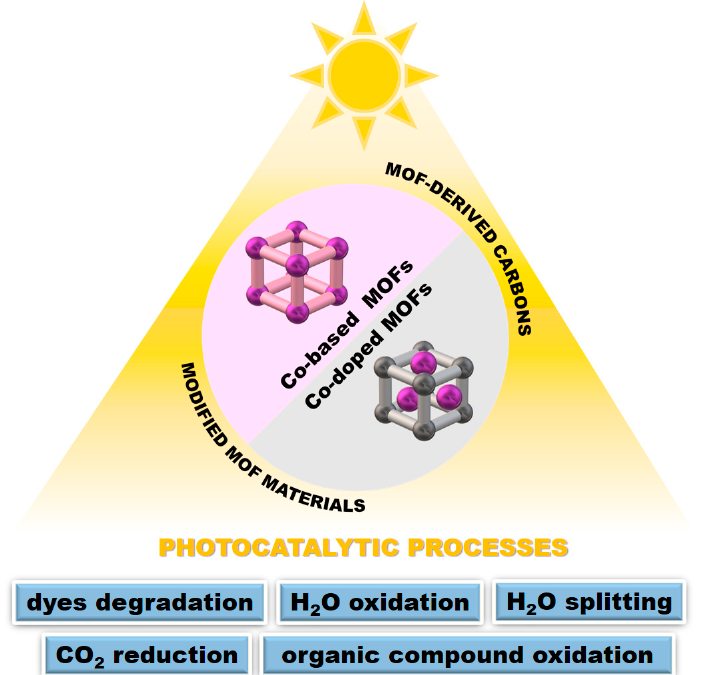
Figure 1. The applications of cobalt-based MOFs, MOFs doped with Co 2+ species, and MOF-derived materials, in various photocatalytic processes i.e., degradation of dyes, water oxidation for O 2 evolu- tion, water splitting for H 2 generation, CO 2 reduction to CO, and oxidation of organic compounds.